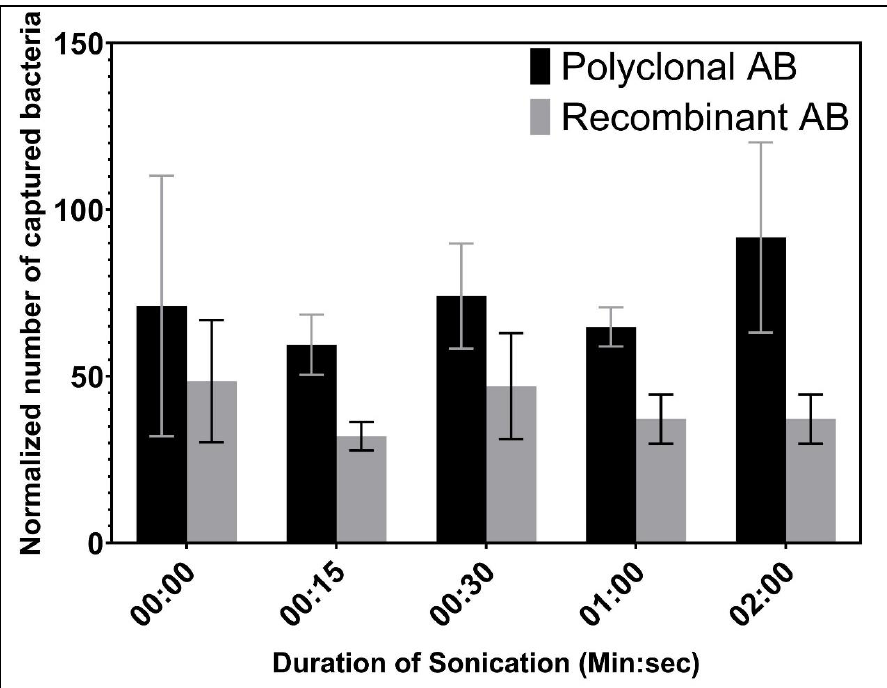
Figure 3. Normalized number of bacteria captured in wells coated with different pre-sonicated Ab and then exposed to L. pneumophila at 10 8 CFU/mL ( n = 3). Capture was quantified by qPCR (MIP primers) and normalized relative to control wells not coated with Ab (background value) ( n = 2). Error bars are shown to indicate standard deviation.